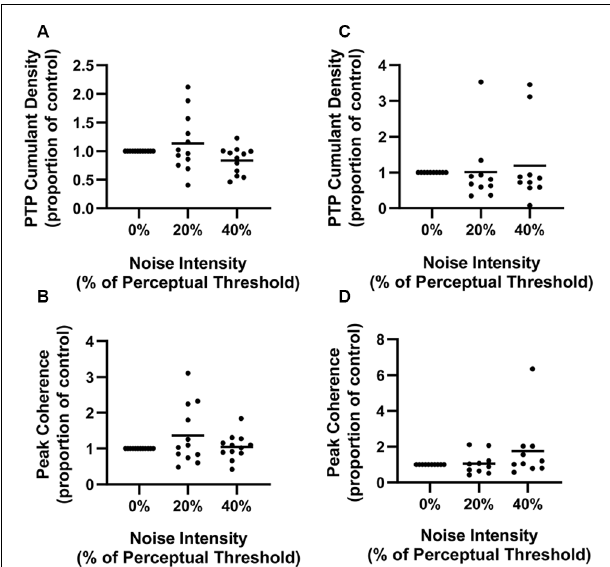
FIGURE 4 | Normalized soleus cumulant density PTP amplitude (A) and peak soleus coherence between 28–32 Hz (B) and normalized tibialis anterior cumulant density PTP amplitude (C) and peak coherence between 28–32 Hz (D) at each noise intensity. Dots represent individual participant data at each noise (soleus: n = 12, tibialis anterior: n = 10) and the horizontal line represents the overall